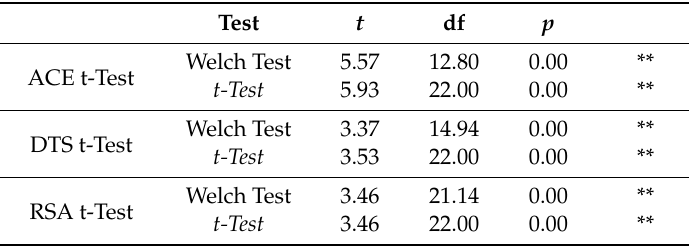
Table 1. The result of the t -test of adverse childhood experiences (ACE), Davidson trauma scale (DTS), and respiratory sinus arrhythmia (RSA) of the healthy group and the trauma